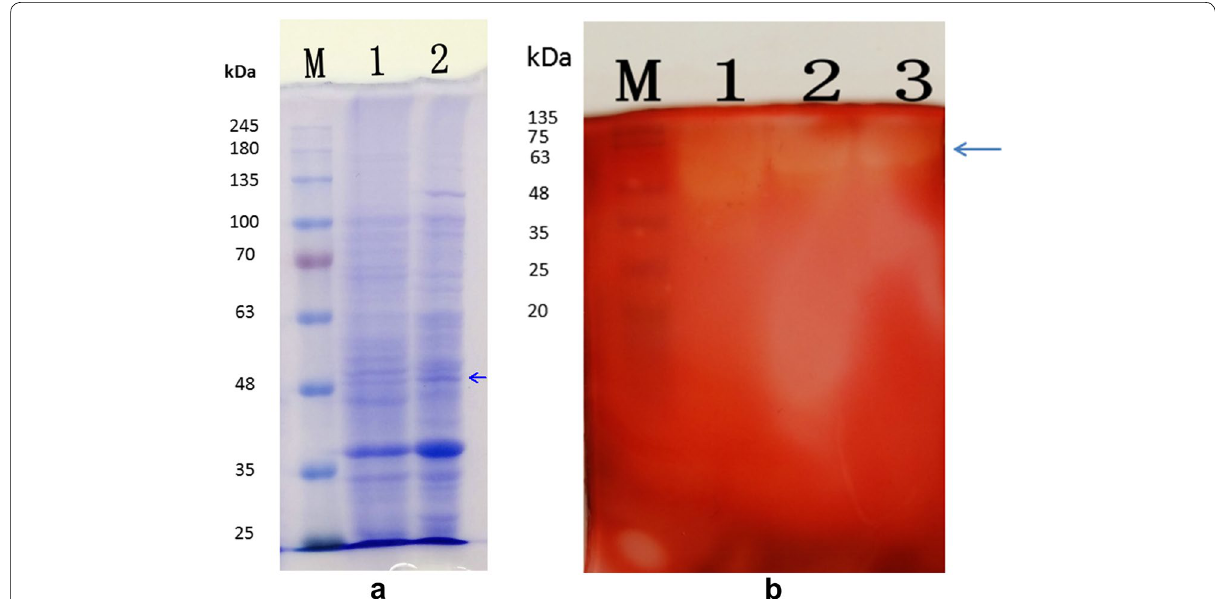
Fig. 5 a SDS-PAGE pattern of endoglucanase from pET21-egls/DE3 purified with ATPS. M Protein ladder; 1 control (without IPTG induction); 2 pET- 21-egls (induced with 1 mM IPTG); b zymogram analysis of crude enzyme and purified Egls. M Protein ladder; 1 crude enzyme (pET21-egls/DE3); 2 purified enzyme (pET 21-egls/DE3)